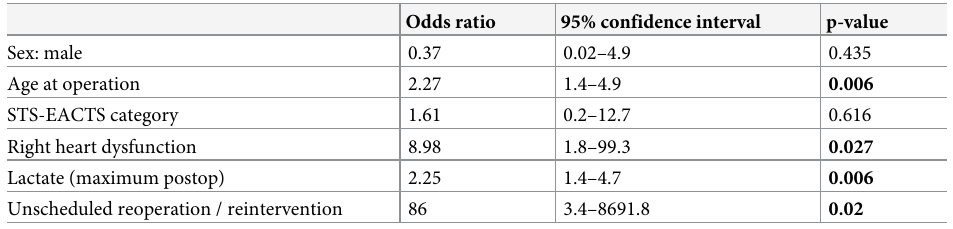
Table 3. Multivariate risk factor